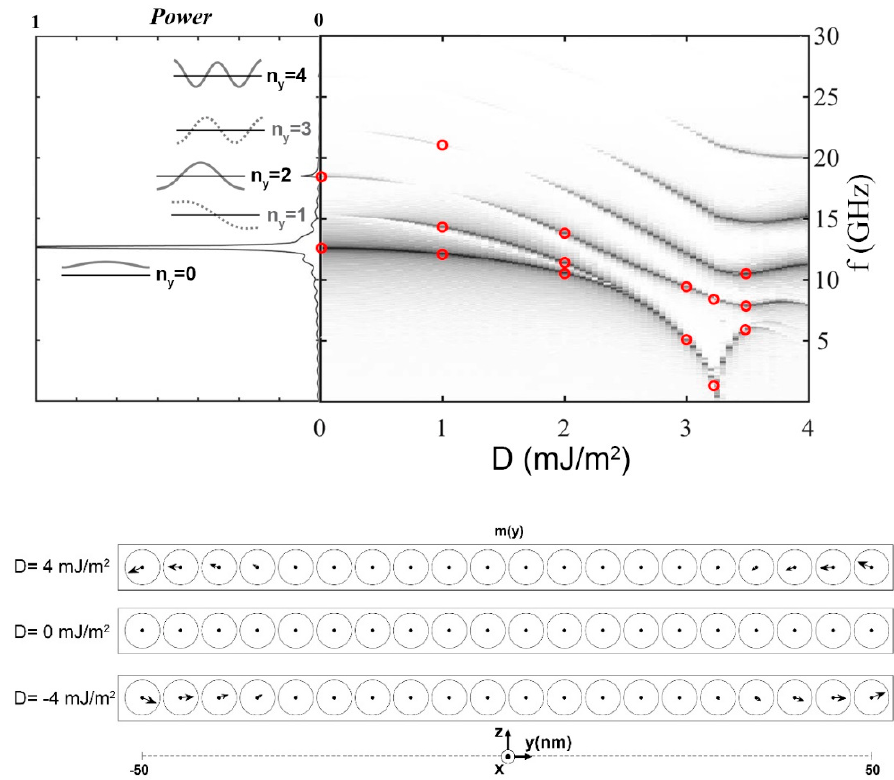
Figure 2. Top panel: dependence of the frequencies of the spin wave eigenmodes on the Dzyaloshinskii–Moriya interaction (DMI) constant D for the wire of width w = 100 nm. The animations with the movies of the dynamics of the main modes for several values of D , corresponding to the red points in the central panel, are available in the Supplemental Material. On the left-hand side, the intensity spectra corresponding to D = 0 are reported, together with a snapshot of the spatial profile of the dynamical magnetization. Bottom panel: representation of the unitary vector of the magnetization of each discrete cell of the wire across the wire width. It is seen that the magnetization of the discretized cells is aligned along the x-direction (easy axis), but for D = 4 mJ/m 2 the magnetization distribution exhibits a chiral state close to the left and right edges, where it is not anymore aligned along the x-direction, as it is in the central region of the wire.